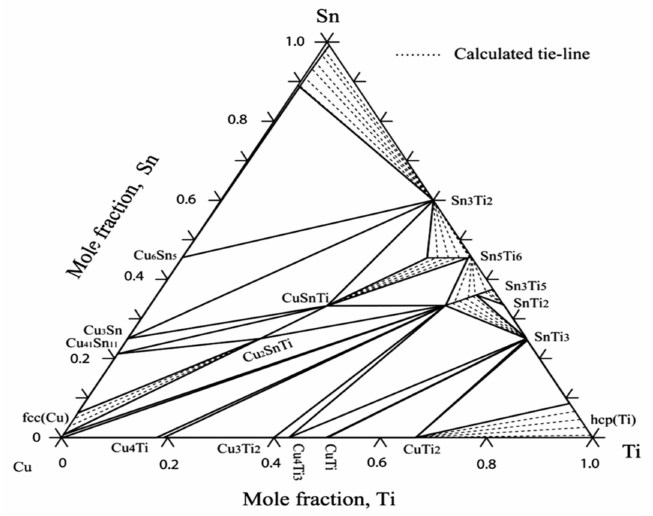
Figure 28. Isothermal section of Cu-Sn-Ti ternary system at 697 ◦ C [69].